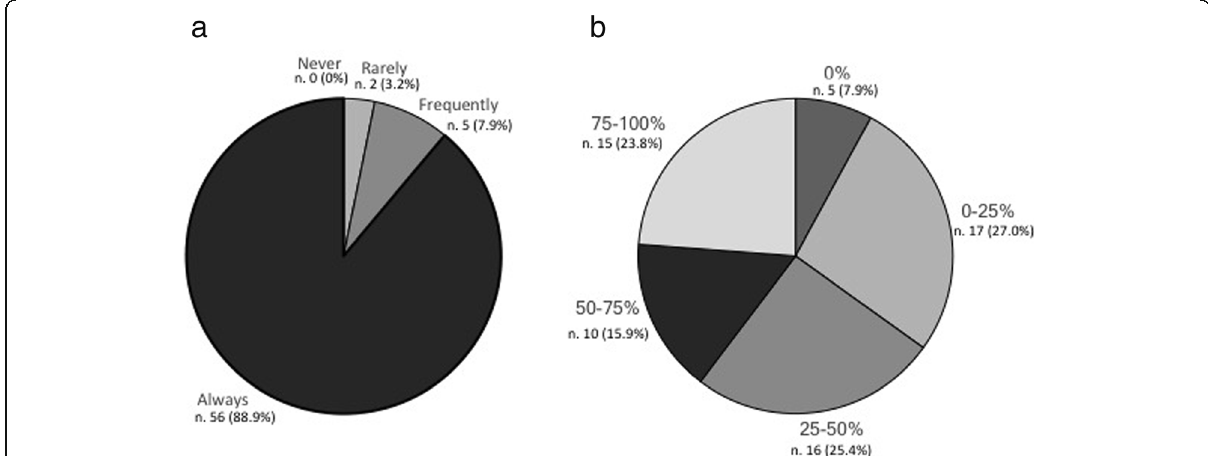
Fig. 1 Compliance of clinicians with the PREEMPT paradigm for Onabotulinumtoxin A (OBT-A) administration: a frequency of use of PREEMPT paradigm; b proportion of patients treated with the follow-the-pain